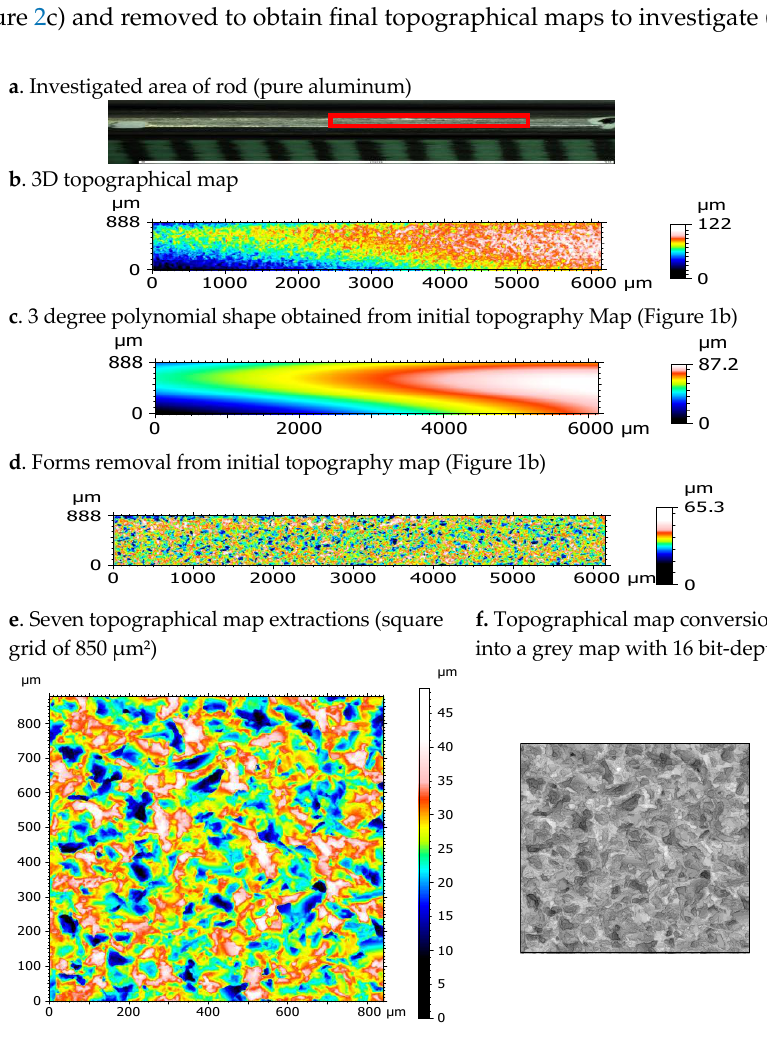
Figure 2. The seven states of treatments of topography measurements to obtain a final 16-bit image.